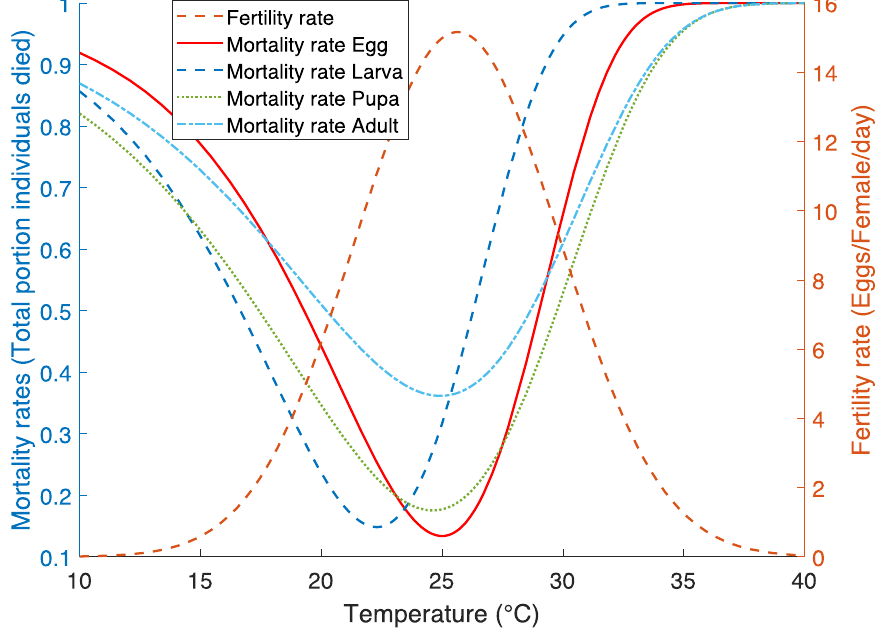
Figure 3. Best-fit mortality rate (7) functions and best-fit fertility rate function (9) for B. oleae . The numerical values of the parameters are listed in Tables 2 and 3, respectively. More detailed plots reporting experimental data and best-fit functions are provided as supplementary material.